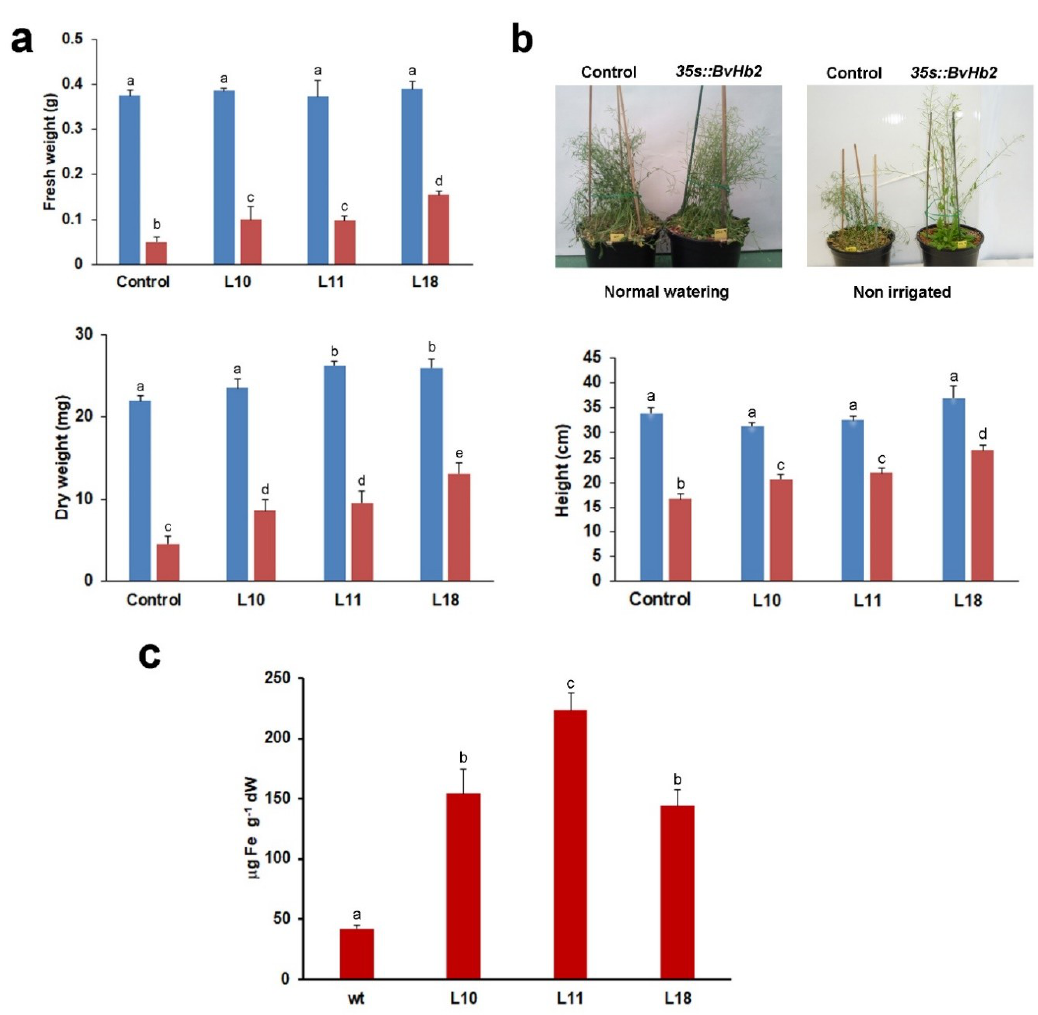
Figure 3. Arabidopsis transgenic lines overexpressing BvHb2 present drought tolerance and increased iron content in leaves. ( a ) Lines overexpressing BvHb2 accumulate more biomass upon osmotic stress. Plants were grown for six weeks in hydroponic MS medium (blue bars) or in hydroponic MS medium containing 120 mM mannitol (red bars). Bars represent means ± standard error. X axis represents the control line (transformed with the empty vector) and the different transgenic lines (transformed with 35S:: BvHb2 ). Data with different letters differ significantly ( p < 0.05), as determined by Tukey’s HSD test ( n = 30). ( b ) Upper panel: Overexpression of BvHb2 conferred resistance to water deprivation. Irrigation was stopped in 3-week-old plants and pictures were taken after 4 days. Lower panel: The height of plants was determined after completing the development (cm) under normal watering conditions (blue bars) or three weeks after stopping the irrigation (red bars). Bars represent means ± standard error. X axis represents the control line (transformed with the empty vector) and the different transgenic lines (transformed with 35S:: BvHb2 ). Data with different letters differ significantly ( p < 0.05), as determined by Tukey’s HSD test ( n = 30). ( c ) Overexpression of BvHb2 increases iron content in leaves. Leaves from 6-week-old plants were obtained. The dry weight was determined, and ions were extracted with HNO 3 . Iron content was determined by atomic absorption spectroscopy. Bars represent means ± standard error. X axis represents the control line (transformed with the empty vector) and the different transgenic lines (transformed with 35S: BvHb2 ). Data with different letters differ significantly ( p < 0.05), as determined by Tukey’s HSD test ( n = 10).